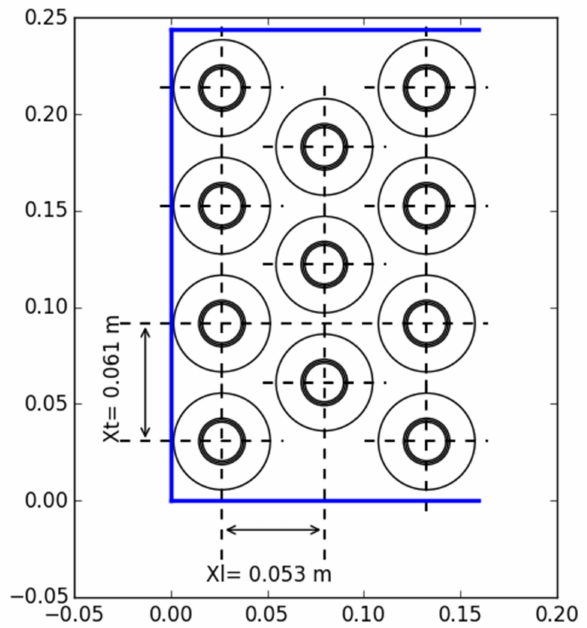
Figure 7. The initial arrangement of the HPs in HPHE